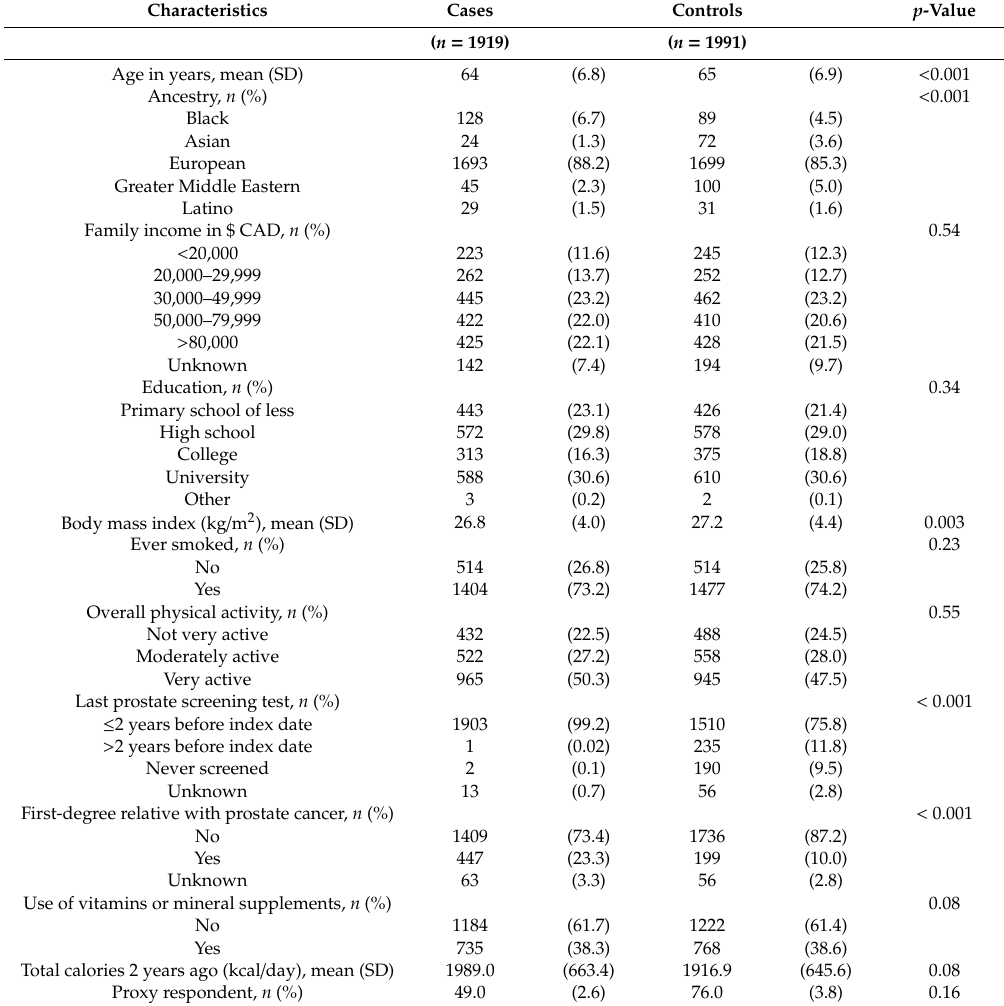
Table 1. Selected characteristics of cases and controls participating in the PROtEuS, Montreal, Canada, 2005–2012.